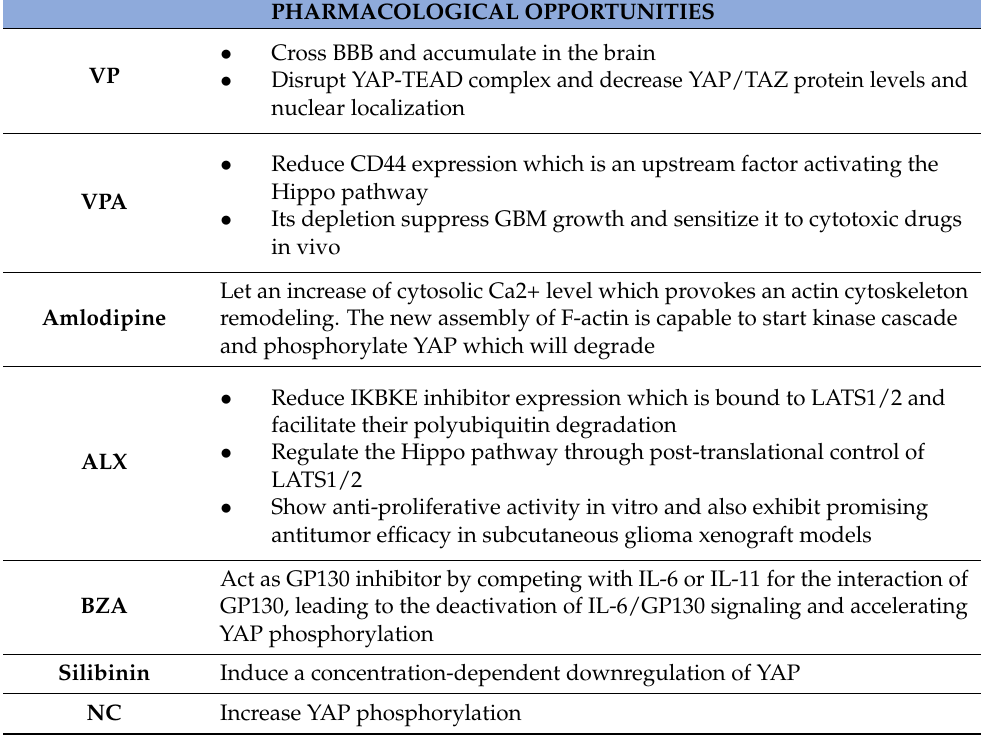
Table 3. Principal pharmacological therapies targeting the Hippo